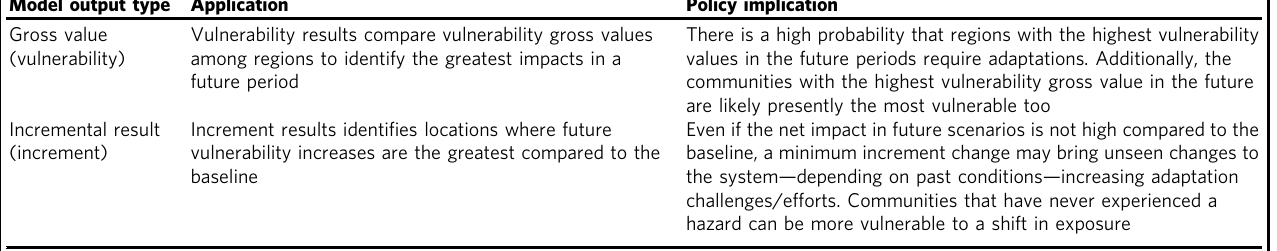
Table 2 Interpretation of ACCVI results